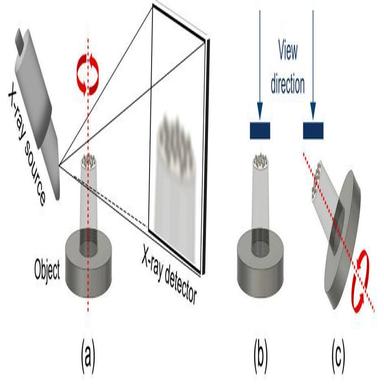
Schematic representations of: CT scanning of powder particles (a) and configurations used for SEM "multi-view" analysis (b, c). Blue arrows correspond to the view direction for both configurations. (For interpretation of the references to colour in this figure legend, the reader is referred to the web version of this article.)